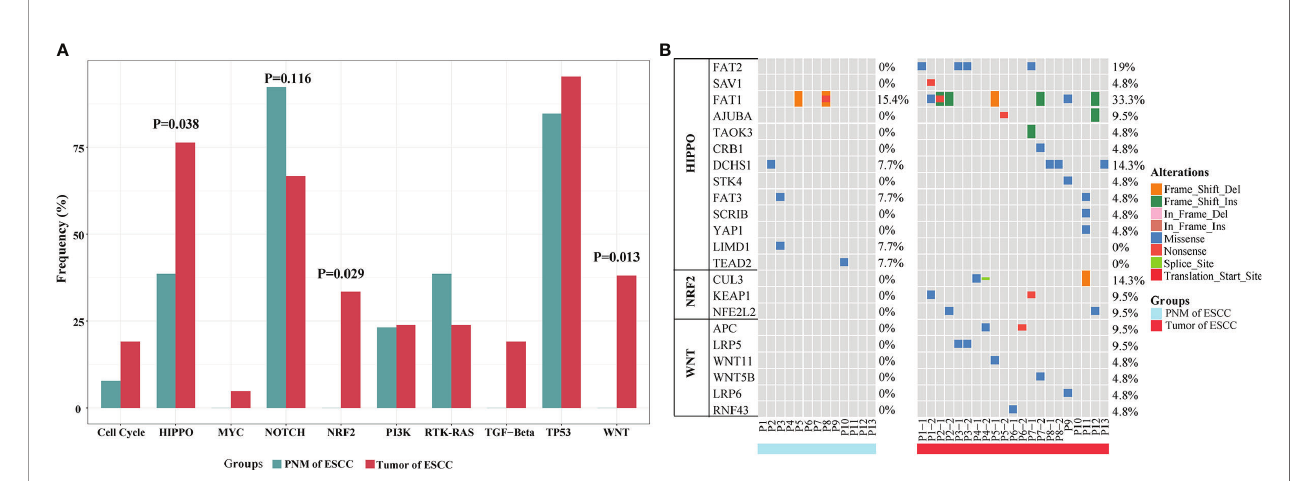
FIGURE 4 | Signaling pathway analysis of mutations in ESCC PNM and tumor. (A) Bar graphs comparing the proportions of patients carrying mutations in the signaling pathway-related genes between ESCC PNM and tumor. Note that the frequencies of the HIPPO, NRF2, and WNT signaling pathways are signi fi cantly different between the PNM and tumor. (B) Details of mutation type and distribution in the genes related to the HIPPO, NRF2, and WNT signaling